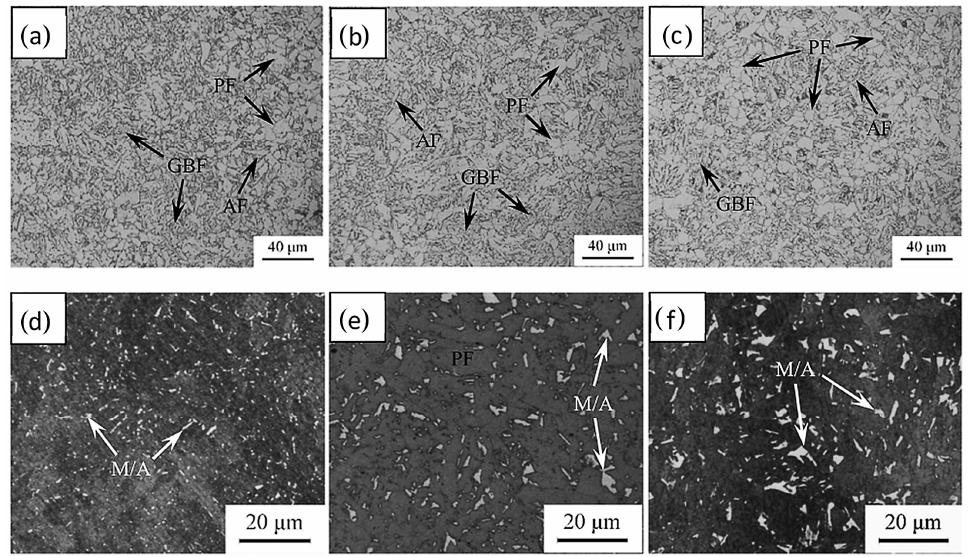
Figure 5. Typical optical micrograph of different CP samples displaying matrix/M ‐ A: CP ‐ A ( a , d ), CP ‐ C ( b , e ) and CP ‐ E ( c , f ). CP—cooling path, M ‐ A—martensite ‐ austenite, PF—polygonal ferrite, AF—acicular ferrite, GBF—granular bainitic ferrite.